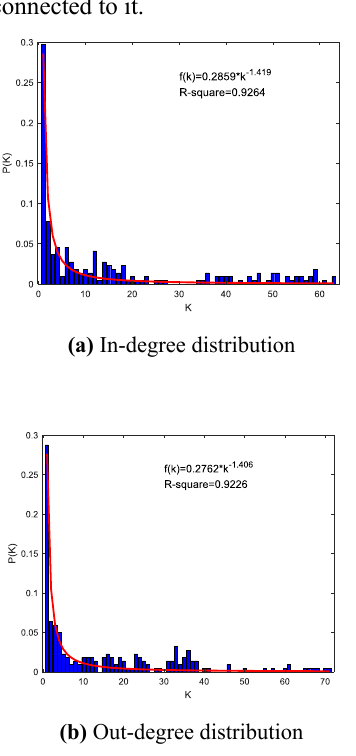
Fig. 2. Degree distribution for network